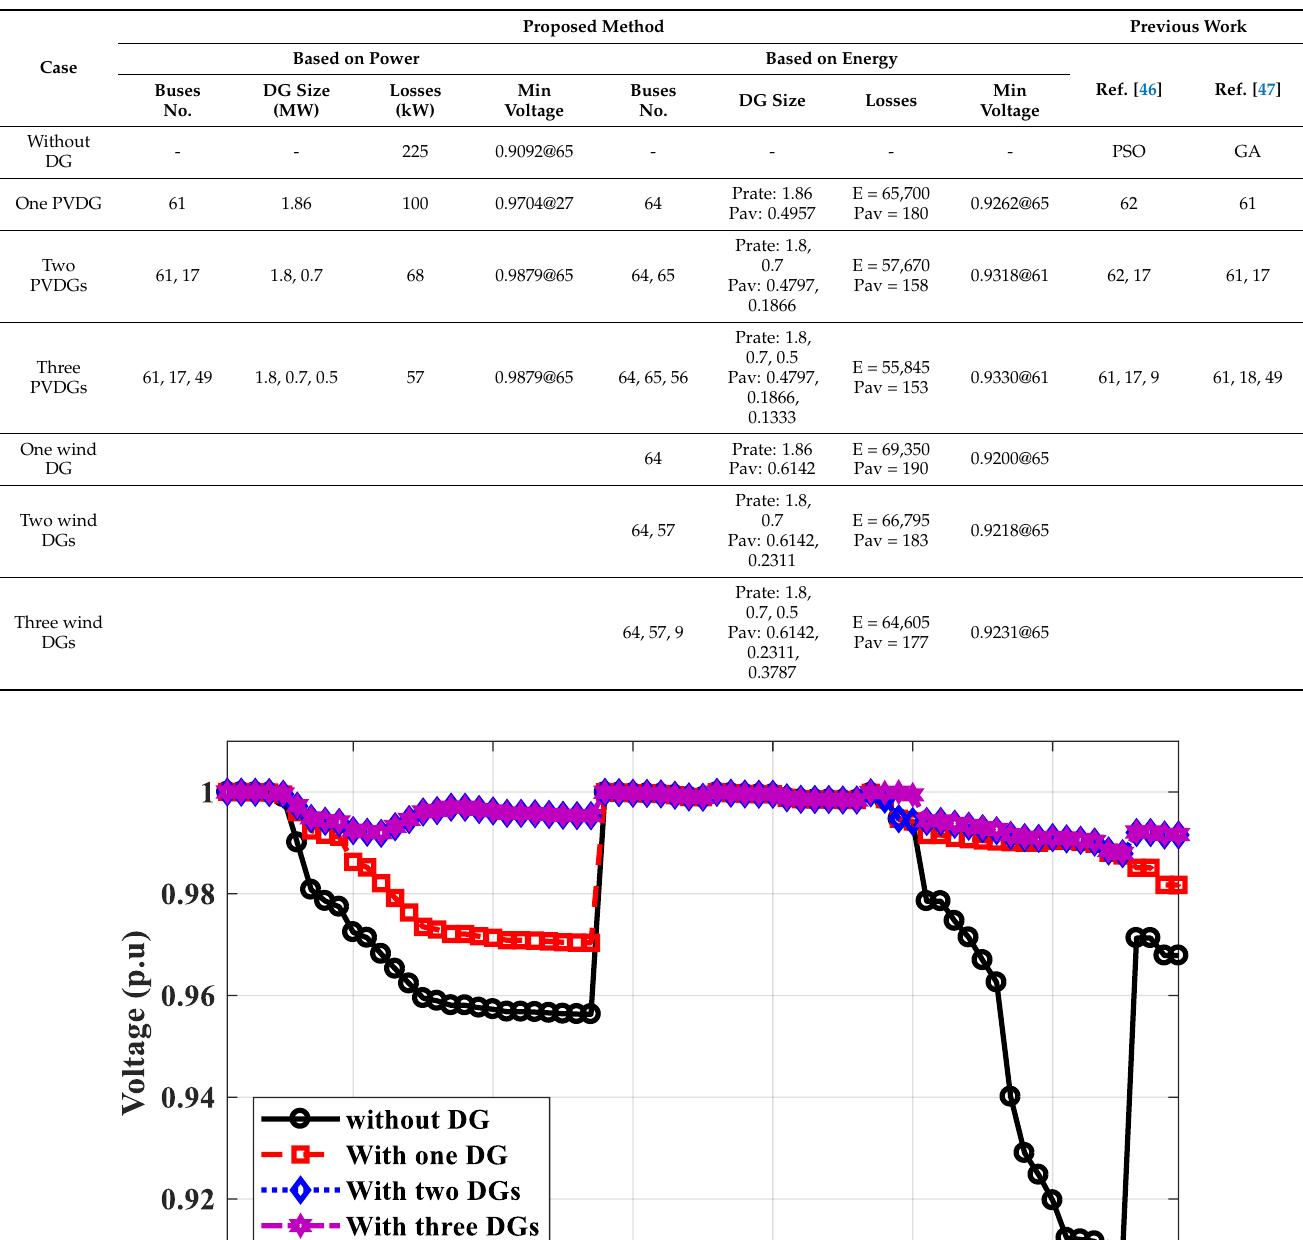
Table 4. The results of the proposed algorithm and compared with previous work.